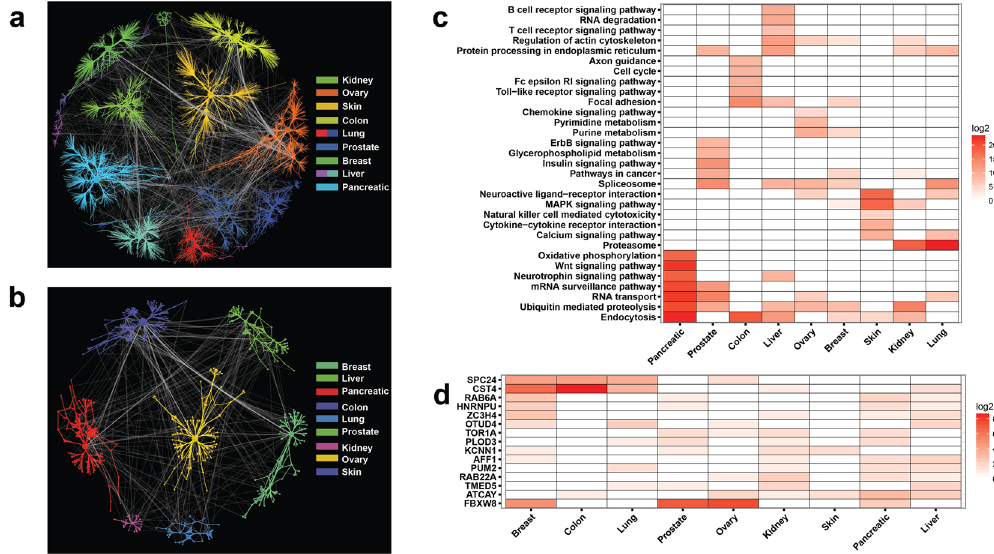
Figure 2. The properties of MALANI-Inferred Networks (MINs) across 9 cancer types. ( a ) Complete MINs reconstructed across cancer types via agglomeration of gene pairs selected by at least three different feature selection methods. Color codes denote different cancer types. ( b ) Shared gene pairs found across at least two cancer types indicated. ( c ) Top 10 enriched canonical pathways for genes residing in MIN for each cancer type. Heatmap plot based on negative of enrichment p-values at log2 scale. ( d ) Heatmap for genes found in MINs of at least 4 different cancer types. Heatmap plot based on the log2 scale of frequency, i.e. number of a given gene appearing in different gene pairs of an inferred